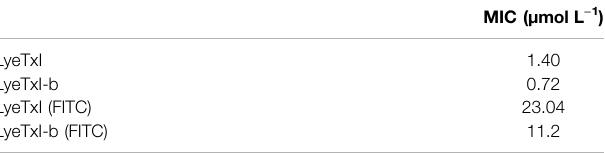
TABLE 4 | Minimum inhibitory concentration (MIC) values for LyeTxI and LyeTxI-b marked with FITC in planktonic S. aureus